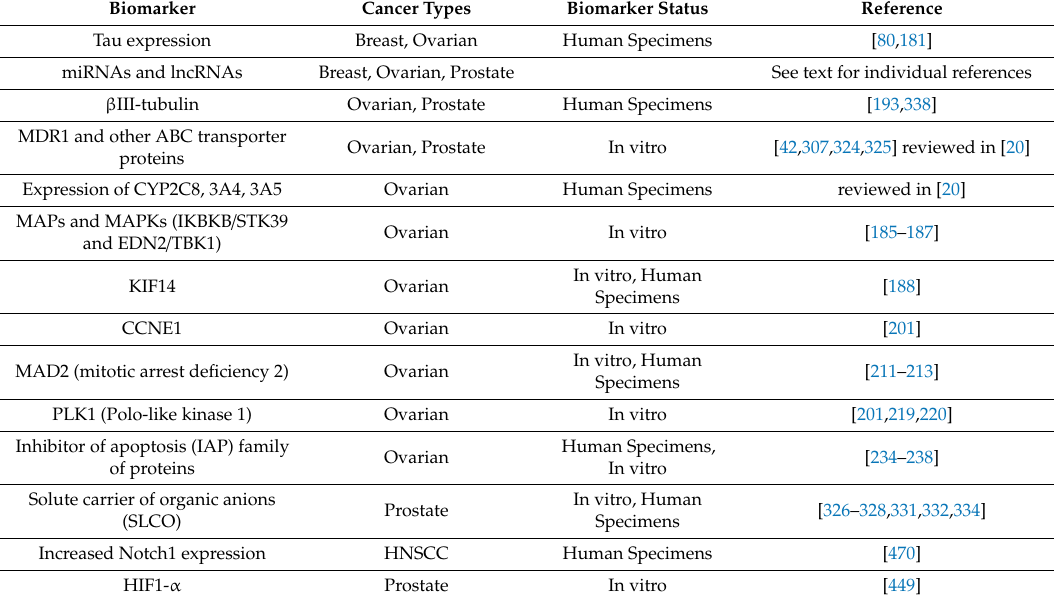
Table 5. Biomarkers of taxane